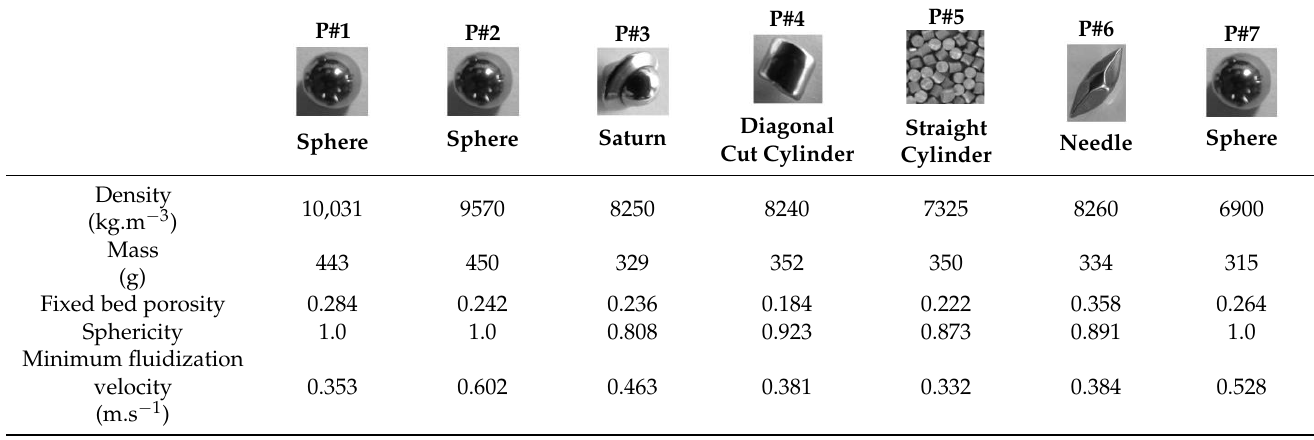
Table 1. Particle characteristics.